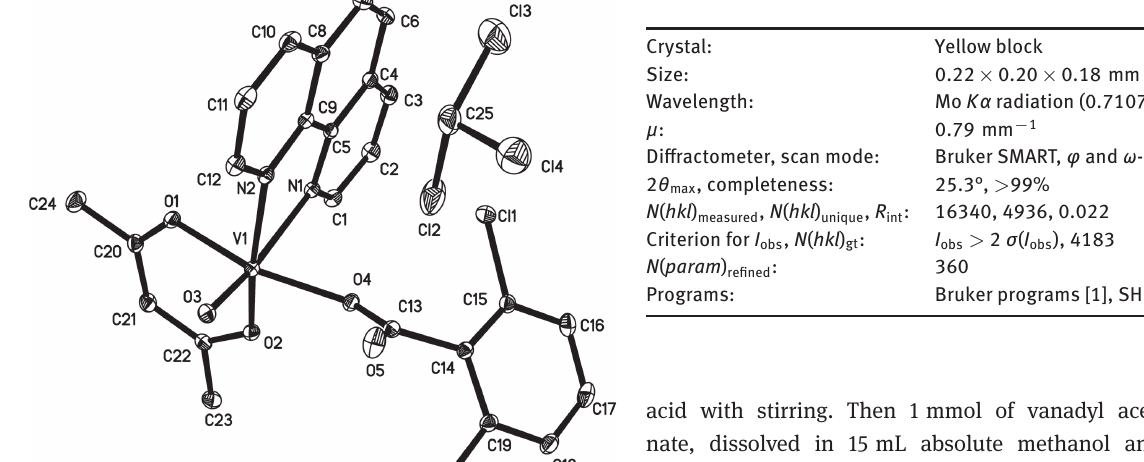
Table 1: Data collection and